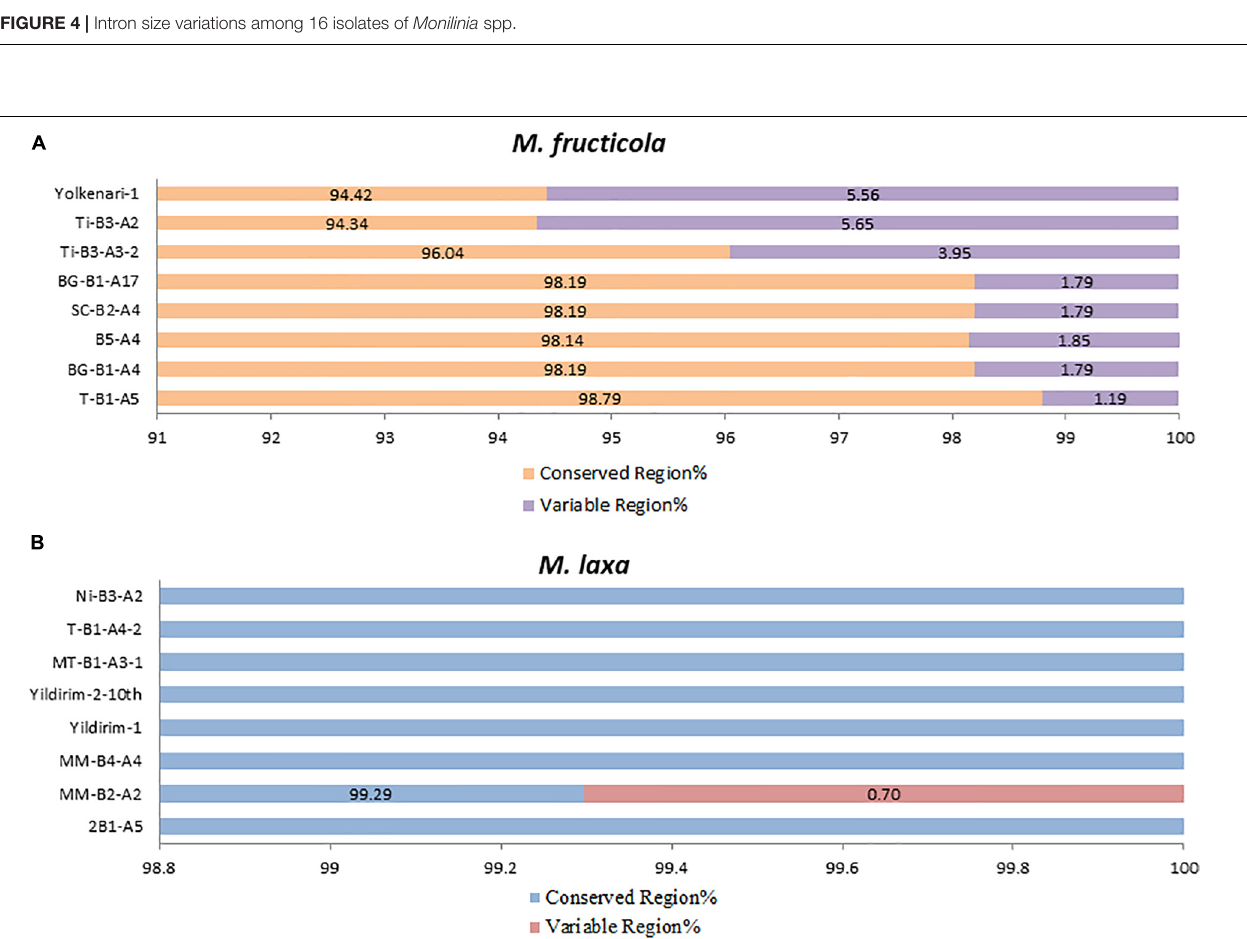
Frontiers in Microbiology |